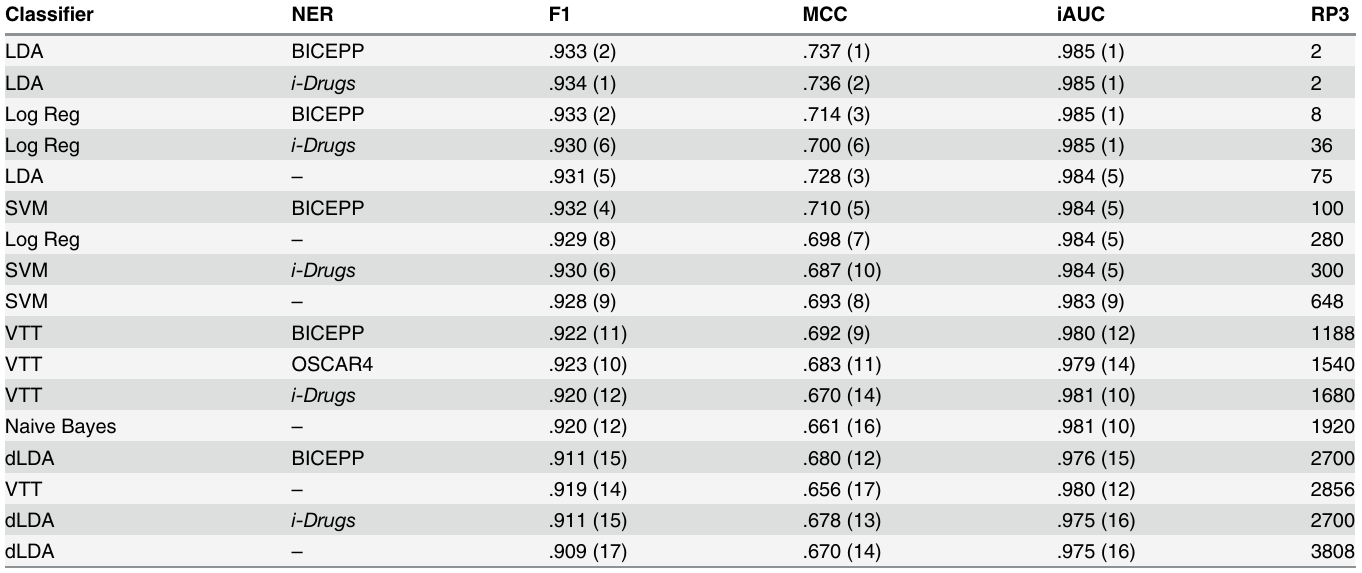
Table 3. Abstract classification performance using NER features. Performance of the best classifiers when specific NER and dictionary features are added; original (bigram runs) classifiers also listed with no NER features (indicated by -). F1, MCC, and iAUC performance measures are listed; the rank of the classifiers according to each measure is reported in parenthesis in the respective column. Classifiers are ordered according to the rank product (RP3) of the three measures (last